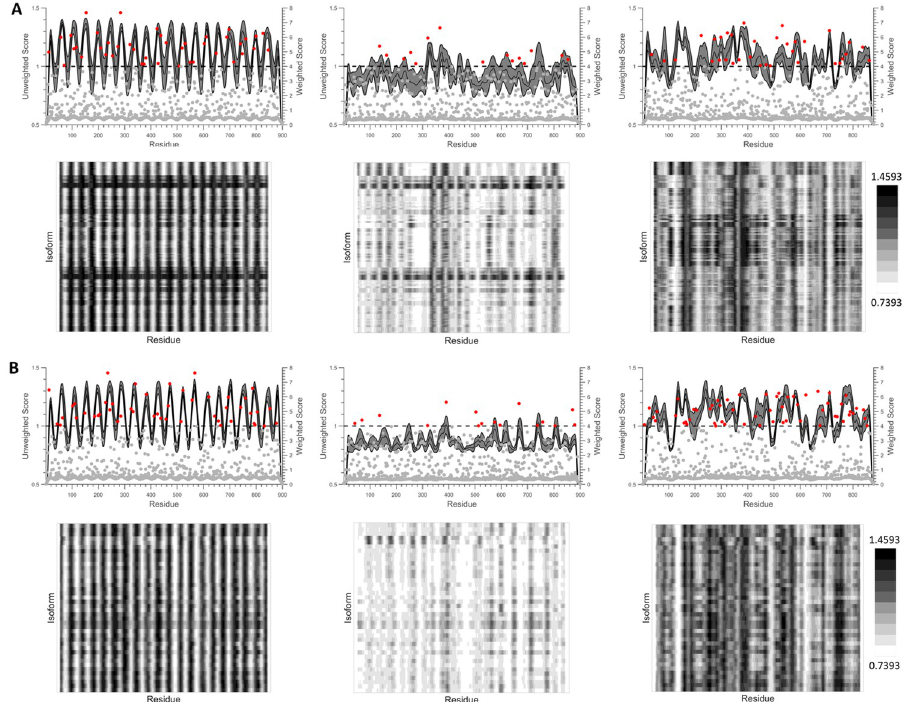
Fig 4. Design and assessment of DQ- and DR-specific UCAs and UCnAs. The plots and heat maps shown here summarize epitope scores for (A) HLA-DQ and (B) HLA-DR isotypes. Top plots display scores for UCAs (1st from left), UCnAs (2nd from left), and a random protein of the same length (3rd from left), in line form (black, UNC) or dot form (red, WNC), plotted against residue number. Center lines represent mean scores and shaded areas represent ± 1 standard deviation. Bottom heat maps display isoform vs. residue number for UCAs (1st from left), UCnAs (2nd from left), and a random protein of the same length (3rd from left). Lighter regions and darker regions within the heat map represent lower and higher immunogenicity scores, respectively.